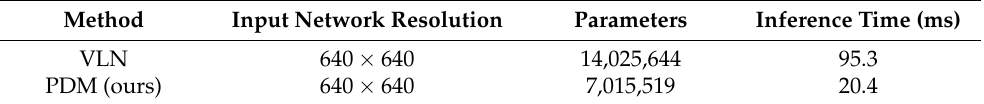
Table 4. The parameters and inference time of different detection modules.